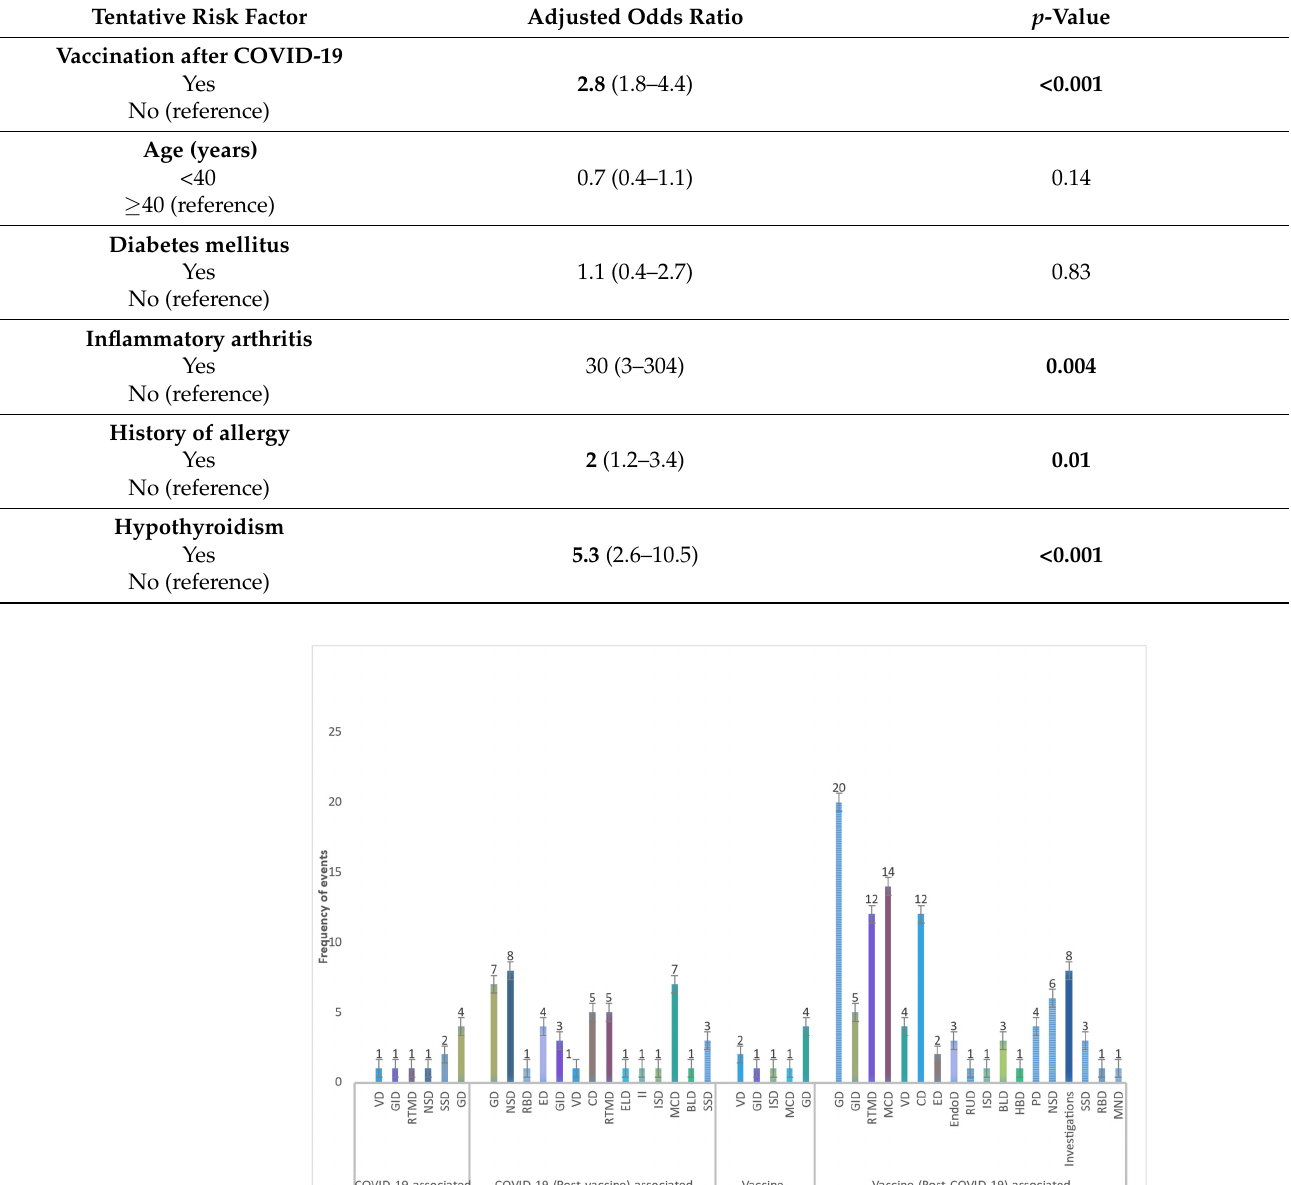
Table 4. Regression analysis to determine risk factors for persisting health issues in health care workers with history of COVID-19 vaccination before or after COVID-19 between February to December 2021.